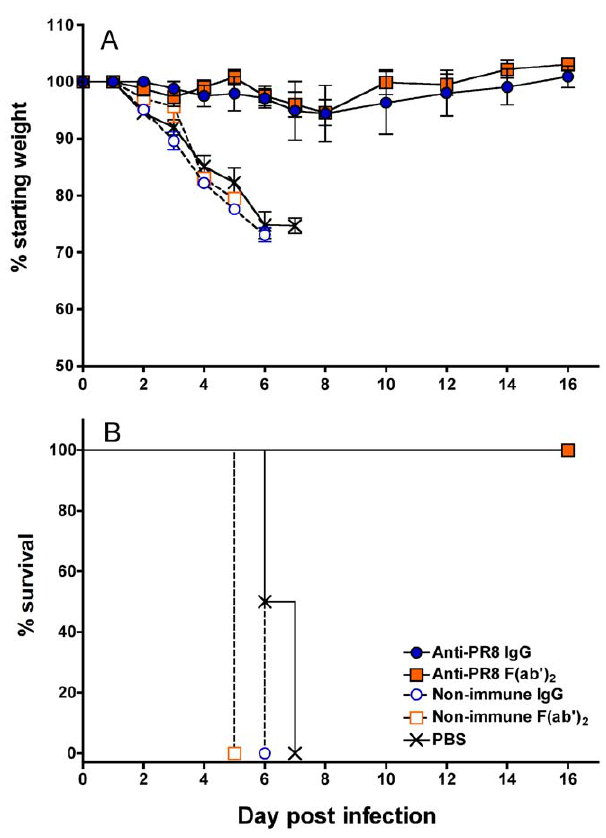
Figure 8. Anti-PR8 IgG and F(ab’) 2 preparations can prevent severe weight loss and death from an established lethal PR8 infection. BALB/c mice (n=4) were infected with a lethal dose (500 pfu in 50 m l) of PR8 virus via the TRT under penthrane anaesthesia. One day post-infection, mice were treated with 1 mg of the Ab preparations or PBS in 50 m l via the TRT route. Mice were monitored daily for 16 days and killed at the humane endpoint. The experiment was performed once in accordance with animal ethics approvals. The change in percentage of the starting weight (A) and Kaplan-Meier survival curves (B) are shown.